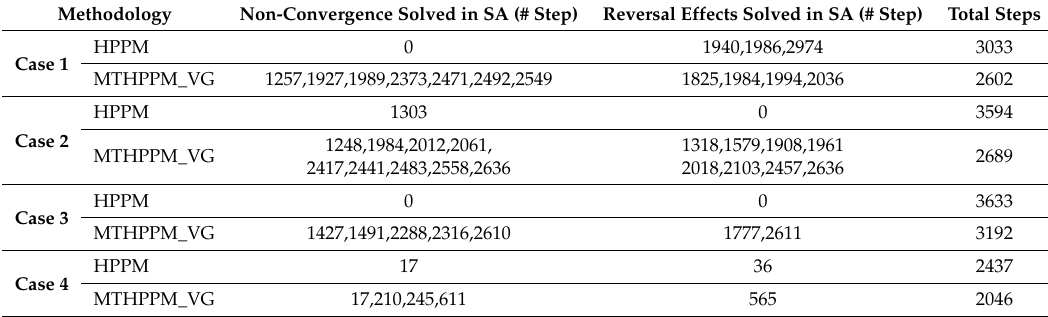
Table 2. Number of reversal effects and non-convergences solved in SA for HPPM and MTHPPM, case studies 1–4, and using DST